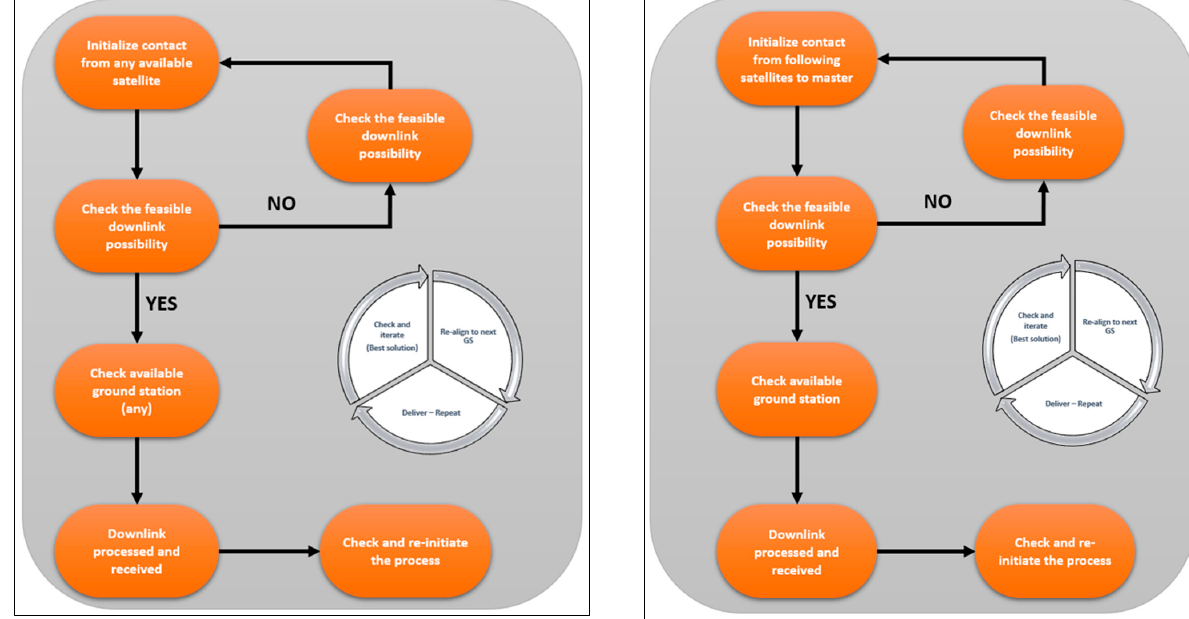
Figure 11. Strategy for the alignment of autonomous ground stations alignment—1 and 2.